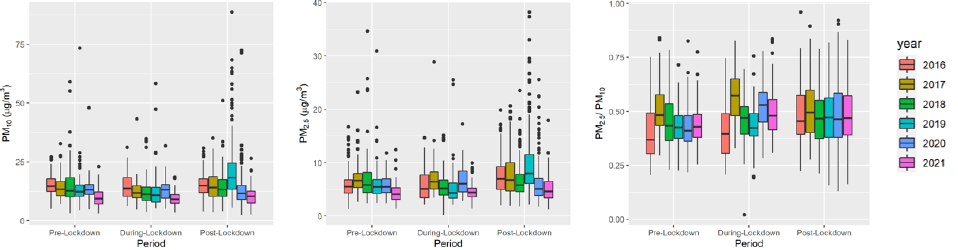
Figure 10. Comparison of PM 10 , PM 2.5 , and PM Ratio for different periods from 2016 to